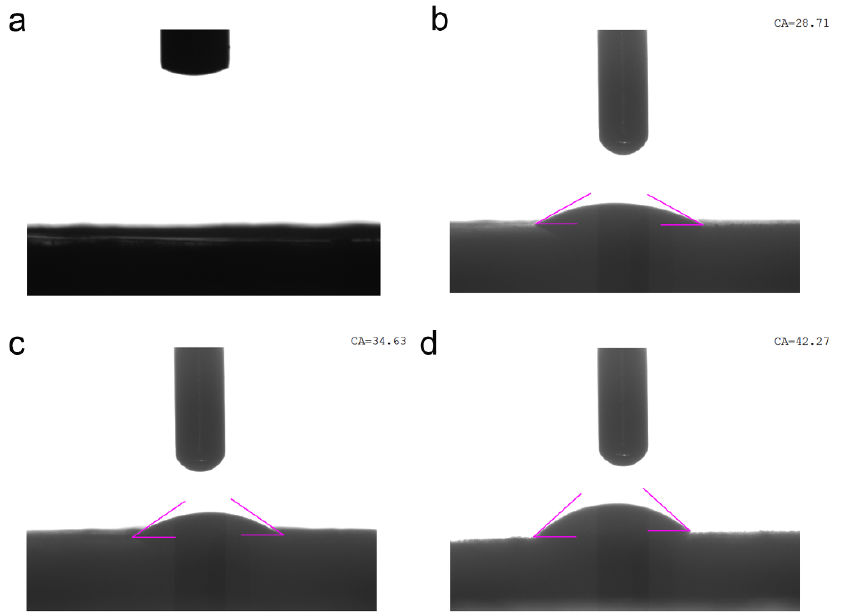
Figure 4. Static contact angles of water on ( a ) CuBTC; ( b ) CuBTC@APTES-1; ( c ) CuBTC@APTES-2; ( d ) CuBTC@APTES-3.